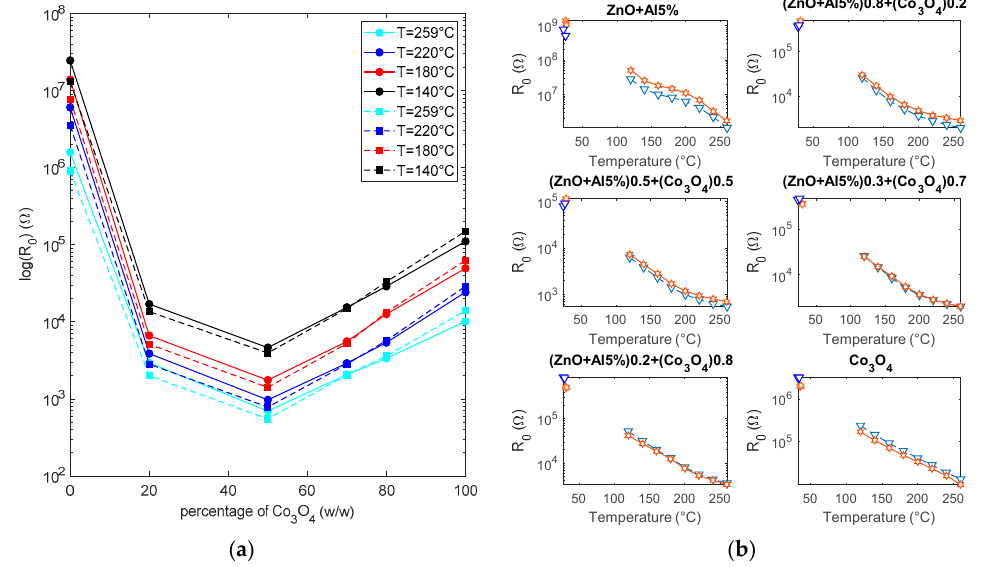
Figure 8. (a) Baseline resistance as a function of the percentage of Co 3 O 4 in the mixtures (w/w). Continuous lines—dry air. Dashed lines—humid air (RH = 50%). (b) Baseline resistance as a function of temperature for the different mixtures. Hexagon markers—dry air, triangle markers—humid air (RH = 50%).